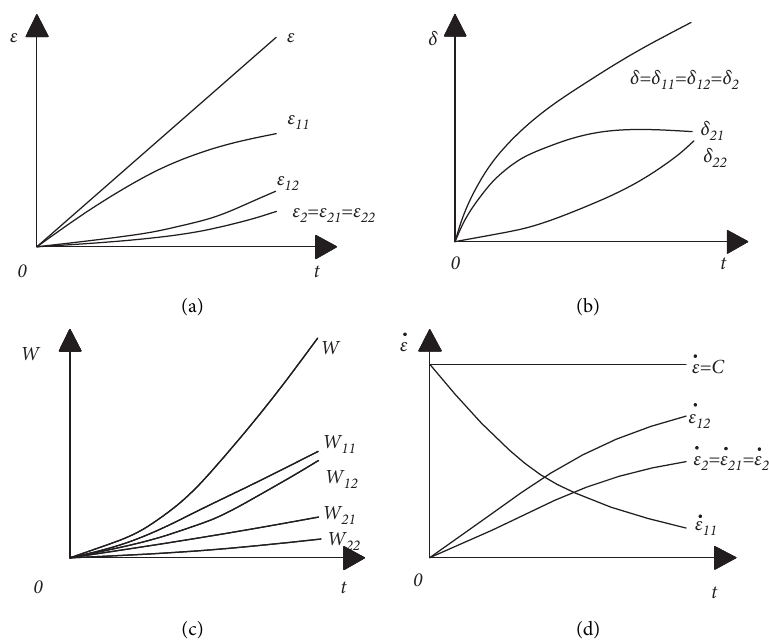
Figure 10: Curves of stress, strain, strain rate, and energy during the coal mine earthquake gestation process. (a) Time history curve of strain. (b) Time history curve of stress. (c) Time history curve of energy. (d) Time history curve of strain